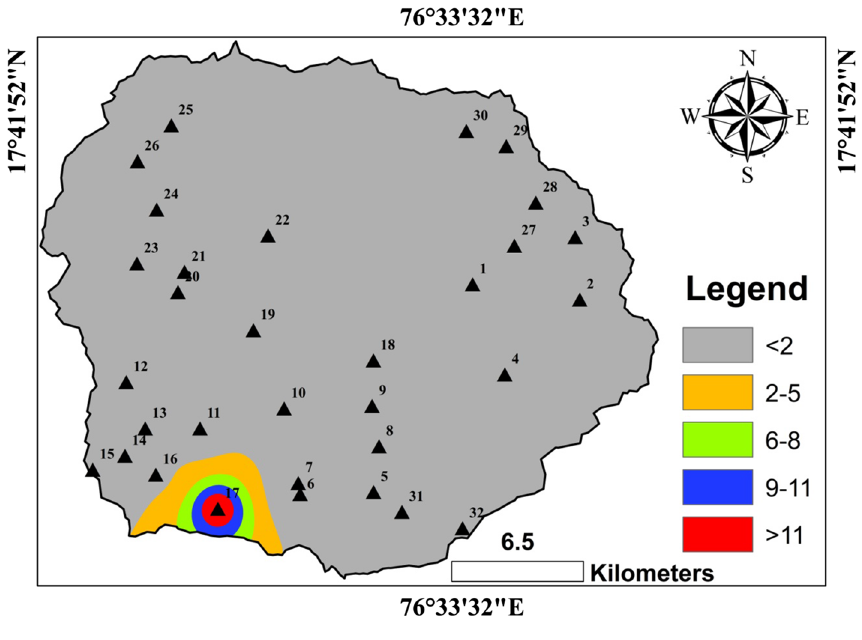
Fig. 19 Geospatial distribution of carbonate